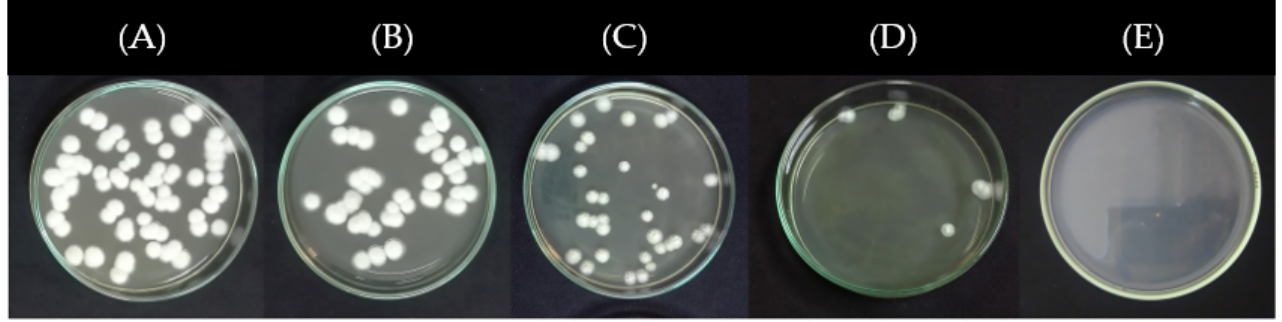
Figure 7. Effect of propolis extracts (LR16) at different concentrations on the germination of Phlyc- tema vagabunda (CP13 isolate) conidia. Lowercase letters indicate statistical differences between propolis concentrations after Tukey test ( p < 0.05). 3.6. Effect of Propolis Extract LR16 on the Control of Phlyctema Vagabunda CP13 Isolate in In Vivo Condition After 20 days of incubation at 20 °C, significant differences ( t -test, p < 0.001) were detected in the rot incidence of P. vagabunda (isolate CP13) in apples that were treated with propolis extract (0.5%) and the untreated. In treated apples, the rot incidence decreased by almost 60%, whereas in untreated fruits, the incidence reached 100% (Figure 8A). In addition, the disease severity, expressed as the rot diameter, was significantly different ( t - test, p < 0.001) between treated and untreated (control) apples (Figure 8B). b